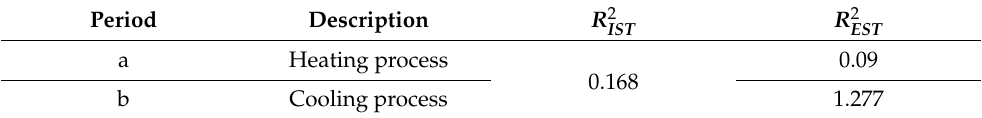
Table 4. Root mean square values for three layers wall configuration h between FEM and experimen- tal